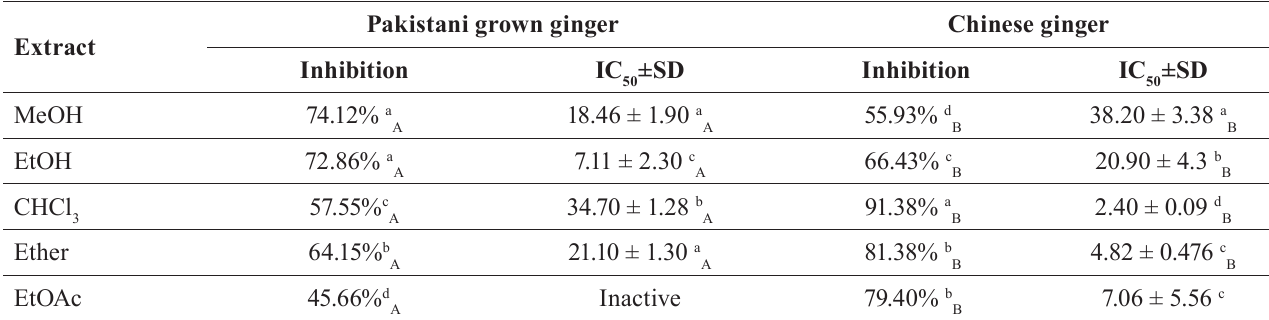
TABLE III - Anticancer activity of extracts from Pakistani grown and Chinese ginger against MCF-7 cell line